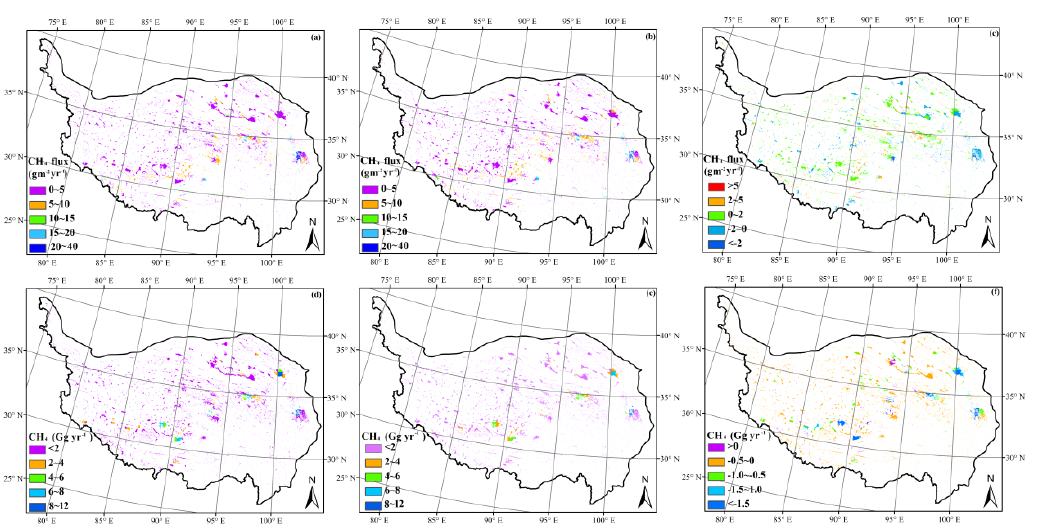
Figure 6. Spatial variations of CH 4 fluxes and regional CH 4 emissions. ( a ) CH 4 fluxes in 1950s; ( b ) CH 4 fluxes in 2000s; ( c ) CH 4 fluxes of 2000s minus 1950s; ( d ) regional CH 4 emissions in 1950s; ( e ) regional CH 4 emissions in 2000s; ( f ) regional CH 4 emissions of 2000s minus 1950s.